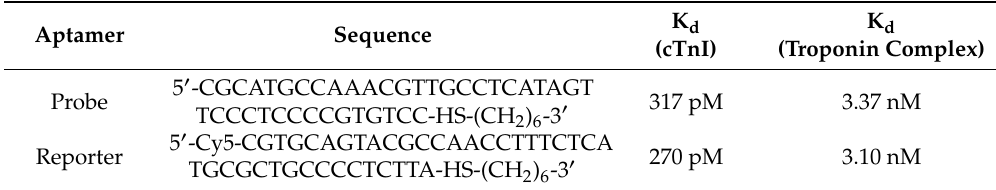
Table 1. Aptamer sequences used in this